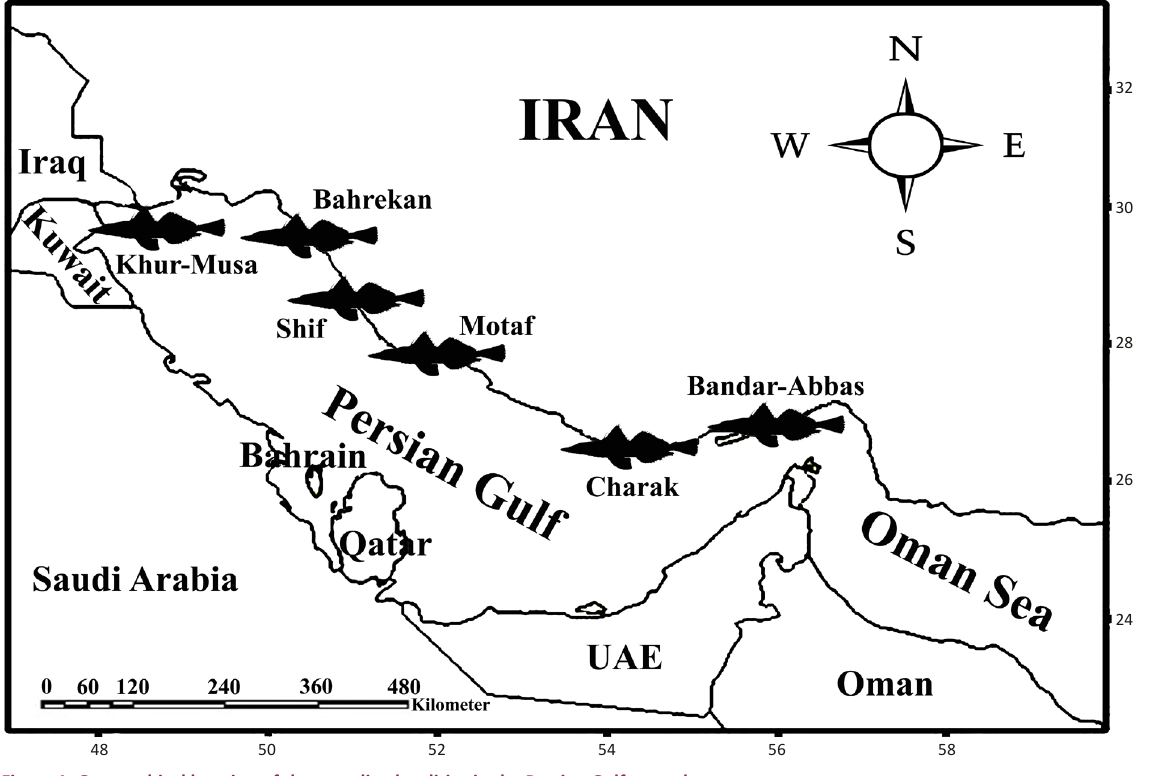
Figure 1. Geographical location of the sampling localities in the Persian Gulf coastal